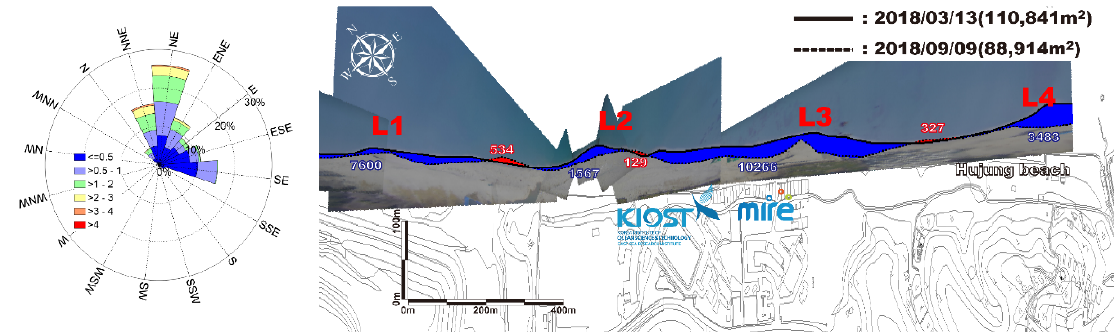
Figure 10. Same comparison as that in Figure 6 but measured at the beginning (13 March 2018) and end (15 August 2018) of T4.